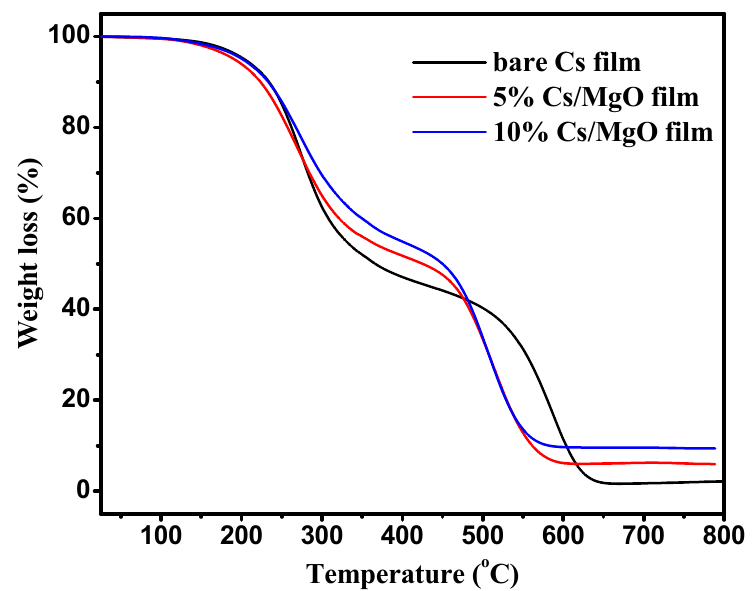
Figure 3. TGA of bare chitosan, 5 wt.% chitosan/MgO and 10 wt.% Chitosan-MgO